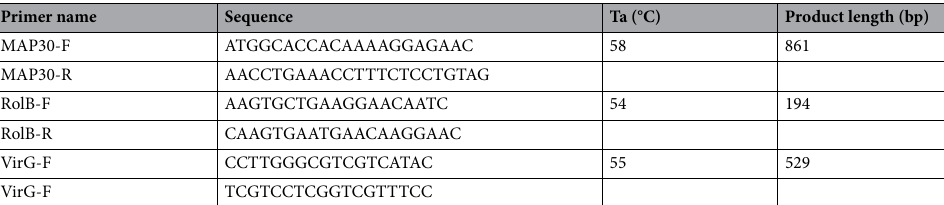
Table 1. Sequences of the primers applied for PCR-based characterization of transgenic hairy roots. Moghadam et al., 2016 designed primers using Vector NTI 11 and Allele ID 7 software19. Ta temperature annealing, F forward, R